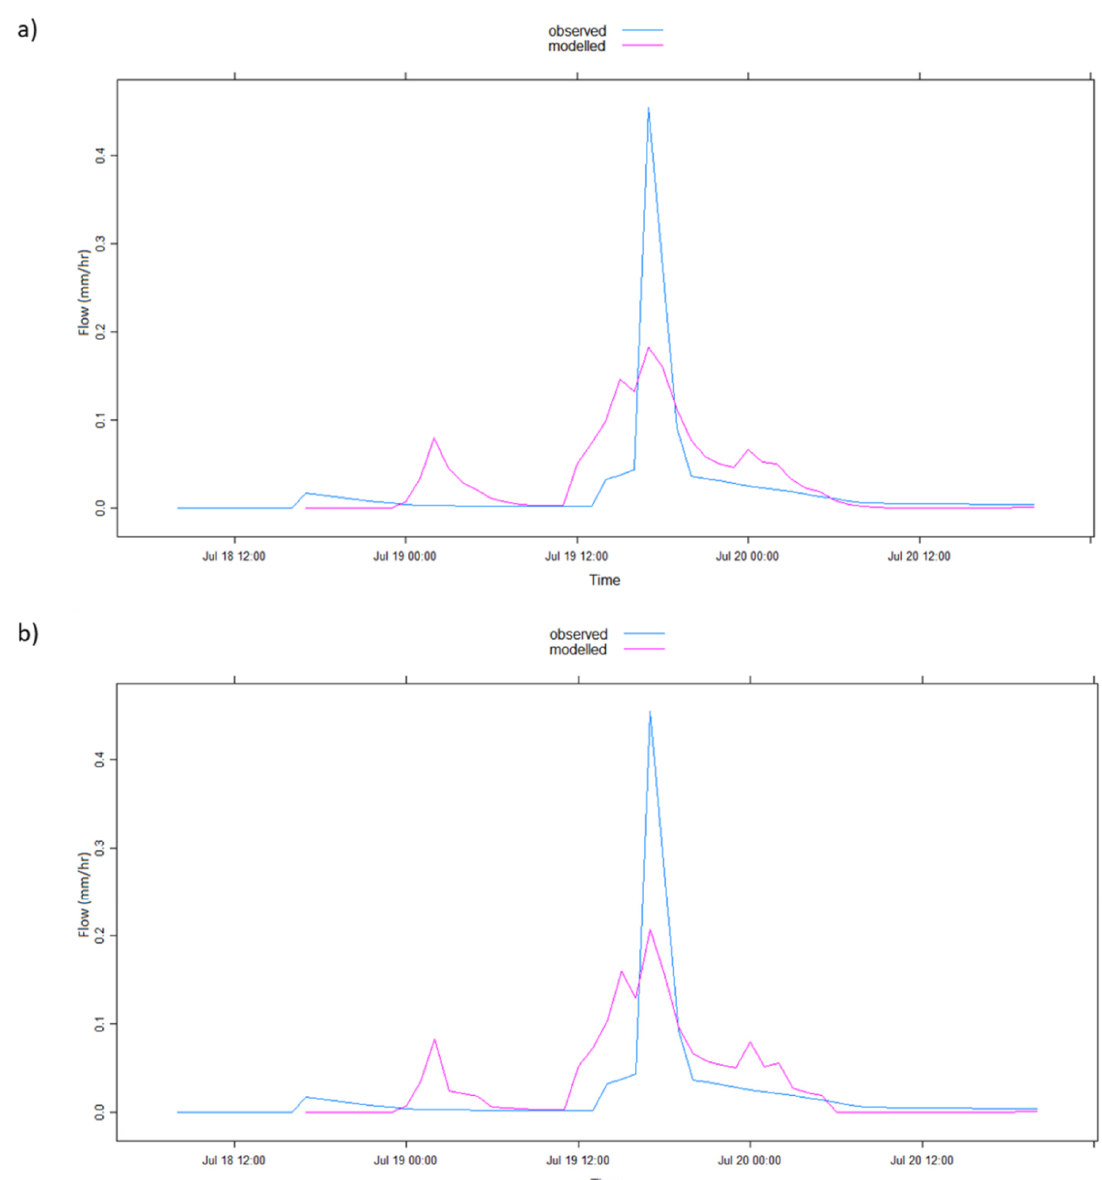
Figure 8. IHACRES model simulation results with ( a ) rsq_daily and ( b ) rsq_hourly objective functions for the 2005 flood event.